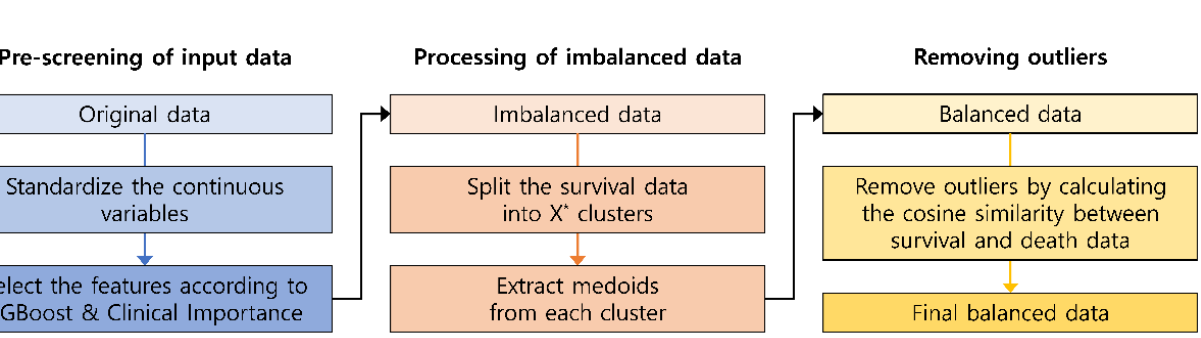
Figure 2. Flowchart of feature selection and preprocessing. Asterisk (*) indicates the number of deaths.